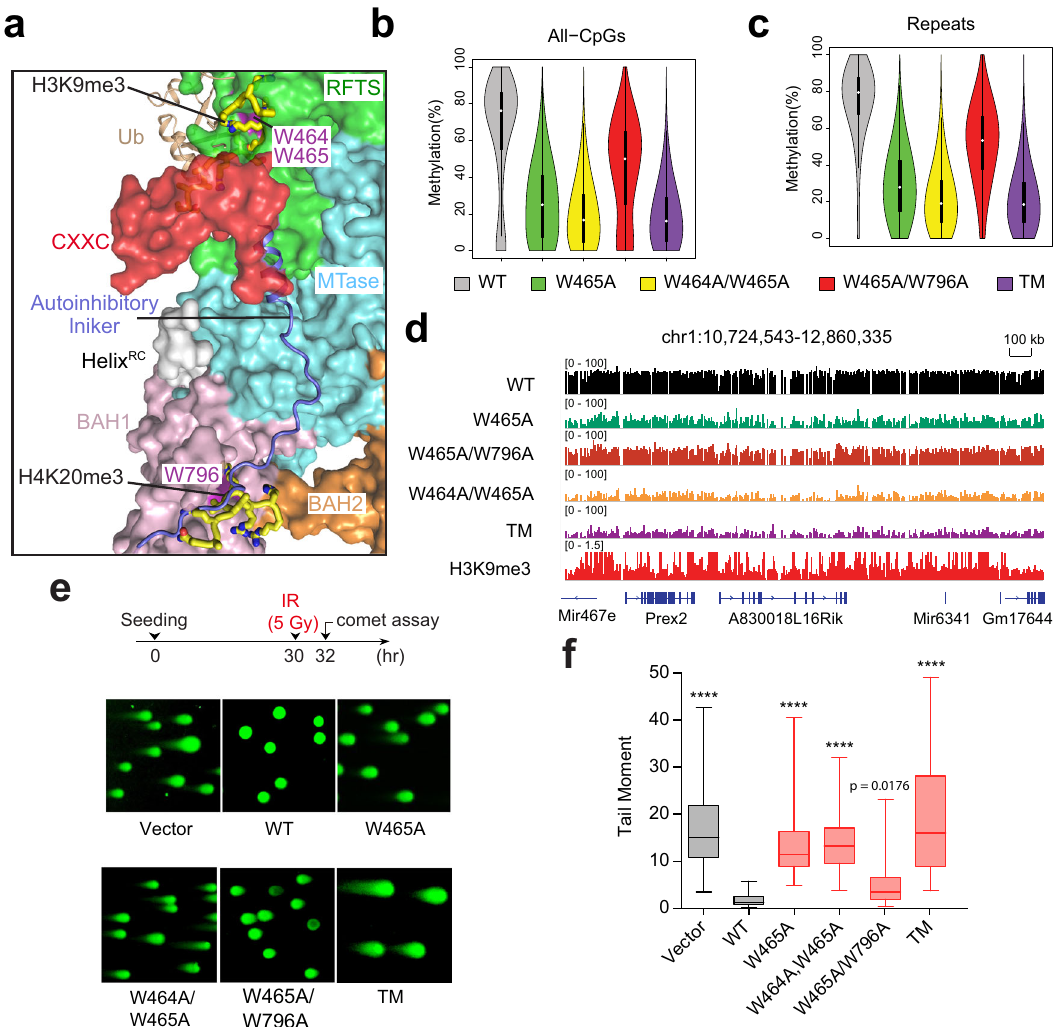
Fig. 5 RFTS and BAH1 domains crosstalk in DNMT1-mediated DNA methylation. a Close-up view of the structurally overlaid hDNMT1 351 – 1600 (PDB 4WXX [10.2210/pdb4WXX/pdb]), bDNMT1 RFTS bound to H3K9me3 and ubiquitin (PDB 6PZV [10.2210/pdb6PZV/pdb]), and the bDNMT1 BAH1 – H4K20me3 complexes, with the surface of individual DNMT1 domains color coded in the same fashion as in Fig. 2a. hDNMT1 W464, W465, and W796 are colored purple. The autoinhibitory linker colored blue. The H3K9me3 and H4K20me3 peptides are shown as yellow sticks. The ubiquitin molecule is shown in ribbon representation and colored in wheat. The bDNMT1 RFTS and bDNMT1 BAH1 molecules were removed for clarity. b , c Violin plots showing distribution of absolute methylation levels for CpG sites with >5 coverage at all CpG sites ( b ) or those within the repeated genomic sequences ( c ) among the indicated cells samples. ( n = 5,040,986 CpG sites in panel ( b ); n = 812,251 repeats in panel ( c )). White dots are the median and box lines are the fi rst and third quartile of the data. d Representative IGV view of CpG methylation at an H3K9me3-marked genomic region located in the chromosome 1 among three replicated 1KO-ESC lines with stable expression of the indicated DNMT1. Cytosines covered by at least ten reads according to eRRBS data (with three replications merged for each group) are shown, with each site designated by a vertical line. e Neutral comet assays, experimental scheme (top) and DNA breaks (bottom). f Quanti fi ed DNA breaks after ionizing radiation (IR) treatment of 1KO-ESC cells reconstituted with vector control or the indicated DNMT1. Box-and-whisker plots in panel depict 25 – 75% in the box, whiskers are 10 – 90%, and median is indicated. Data are mean ± s.d. from >100 cells ( n = 3 biologically independent replicates). One-way ANOVA with post Tukey analysis was used. **** p < 0.0001. The data for vector, WT, W465A, and W464A/W465A were adopted from those published previously 29